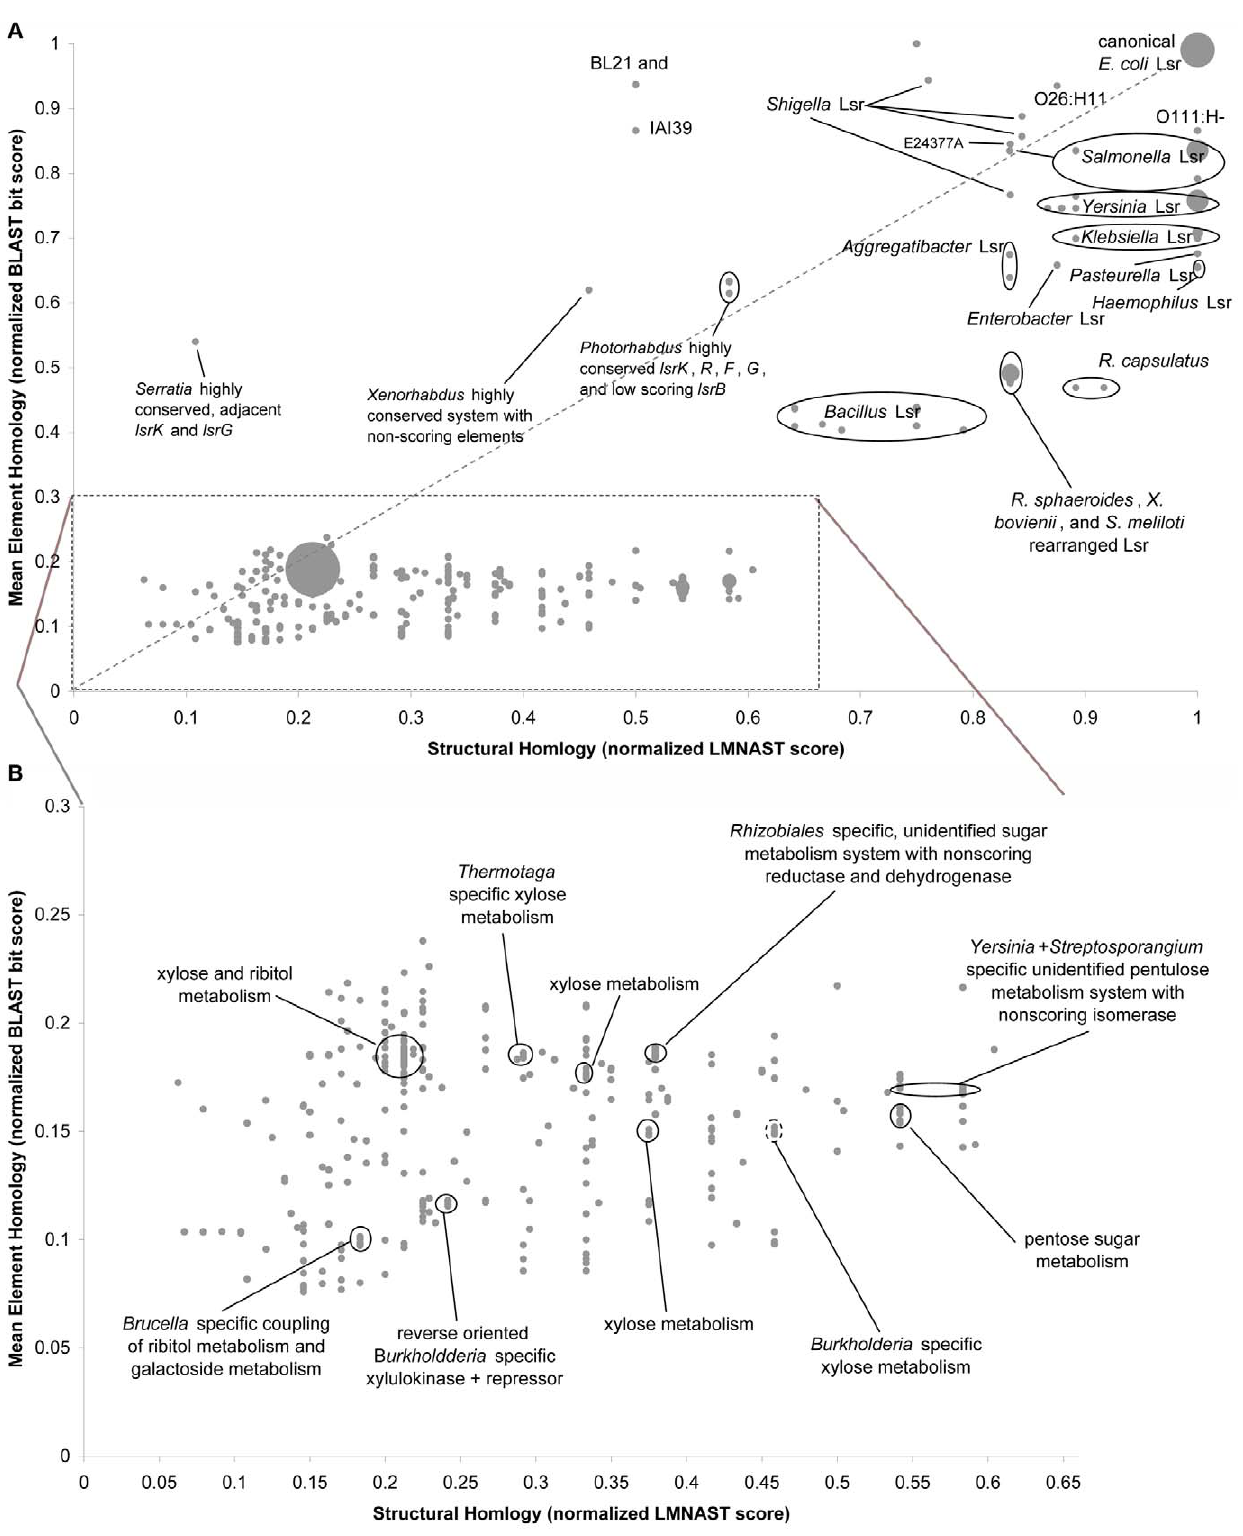
Figure 7. Annotated 2D similarity plot for Lsr system LMNAST weak search hits. A. HGT of homologous systems is evident among hits with perfect organizational homology but diminished mean element homology. A great number of hits have low similarity along both axes. As seen in B., these hits are mostly involved in the metabolism of 5 carbon carbohydrates according to their annotation. This is likely reflective of the fact that AI-2 is of similar structure to 5 carbon sugars.